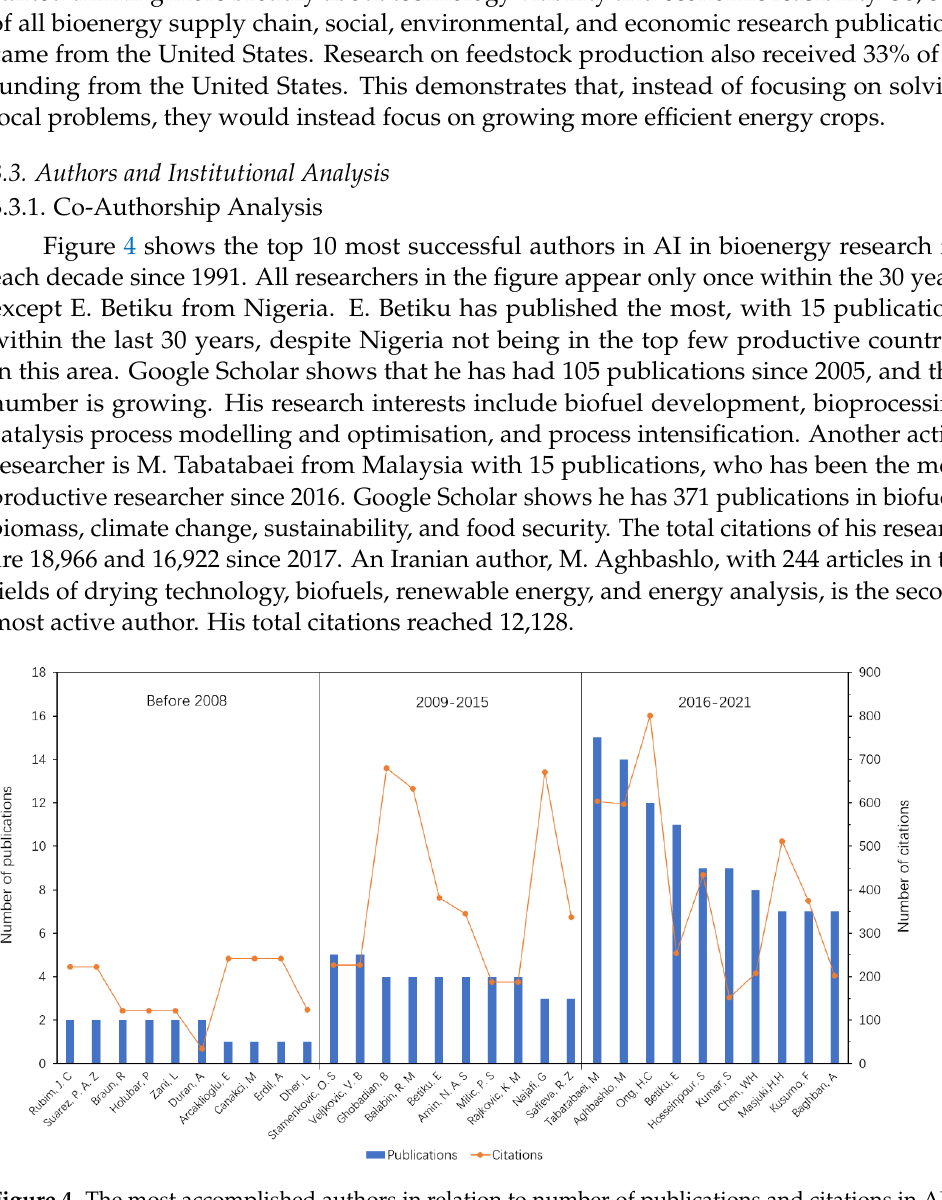
Figure 4. The most accomplished authors in relation to number of publications and citations in AI in bioenergy research between the years of 1991 – 2021.